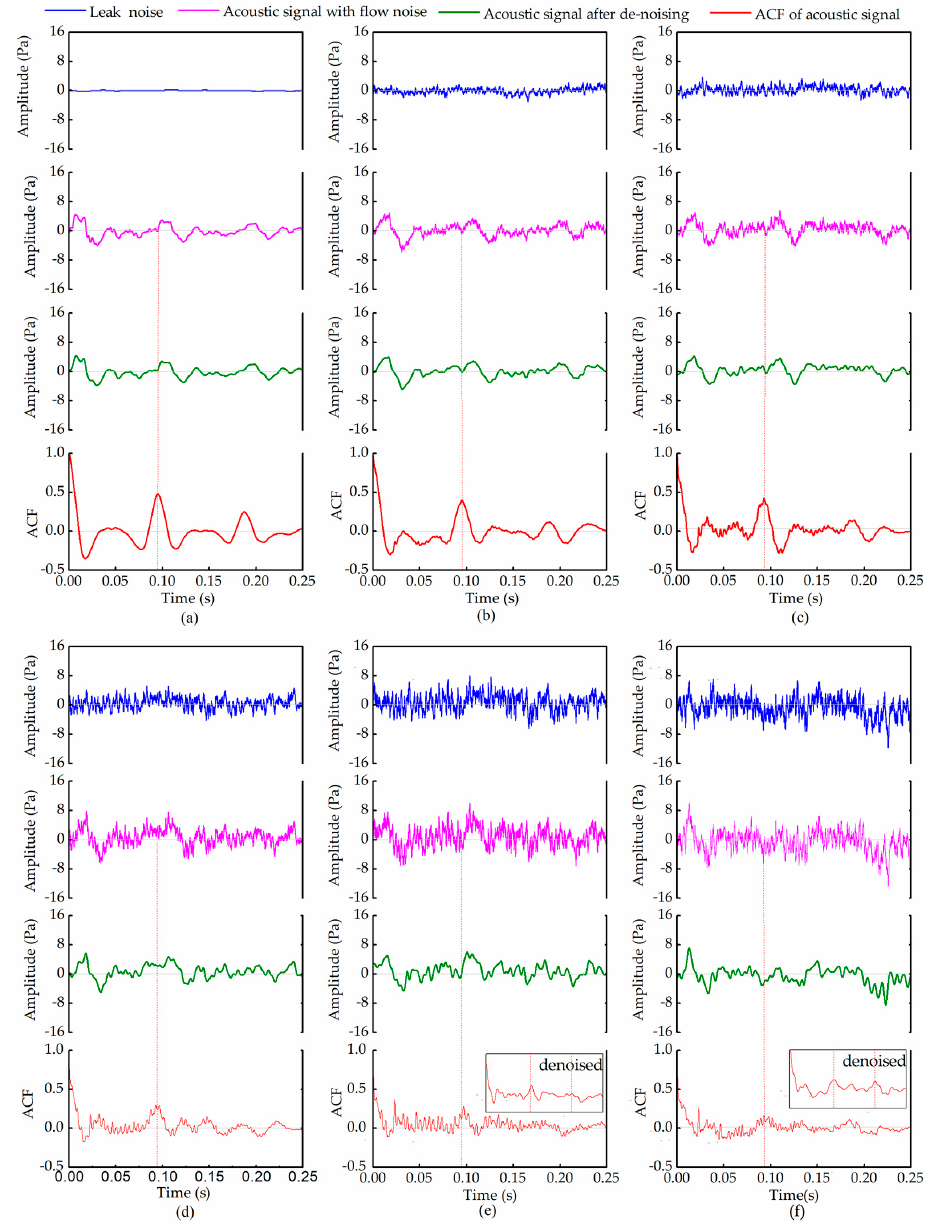
Figure 14. Waveform of FFT and ACF under different annulus pressures of ( a ) 0.16 Pa; ( b ) 0.70 Pa; ( c ) 0.90 Pa; ( d ) 1.40 Pa; ( e ) 2.20 Pa; ( f ) 2.40 Pa.